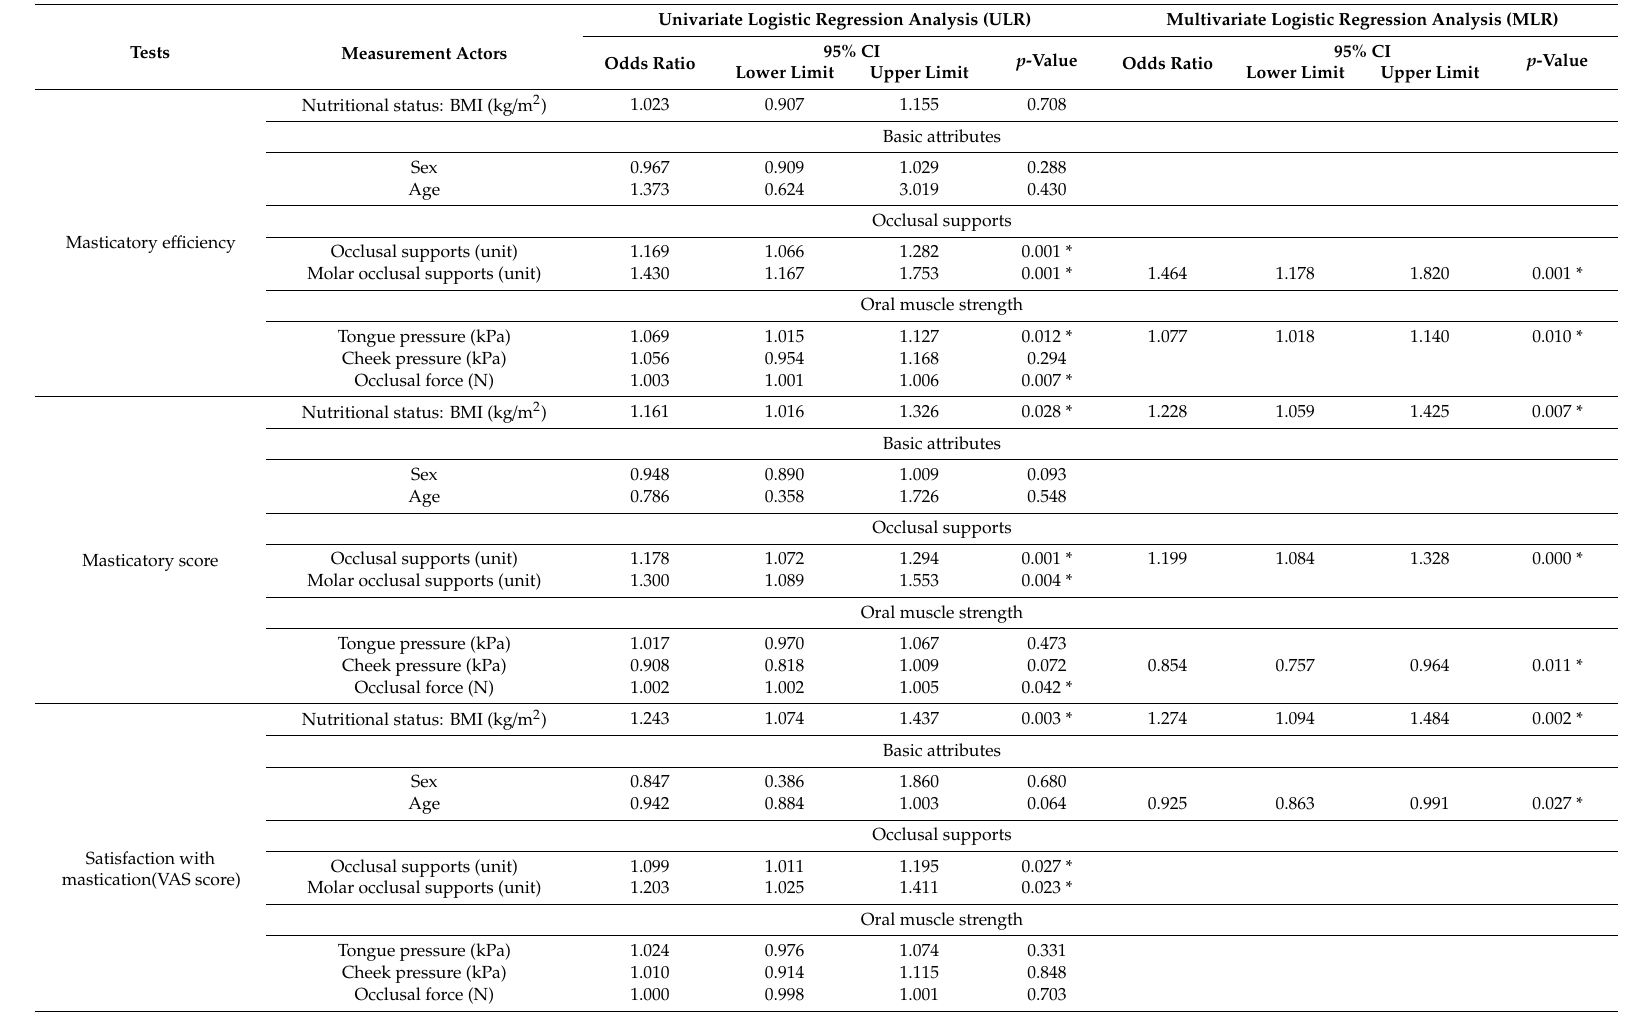
Table 4. Regression analysis of the association between oral factors and masticatory ability